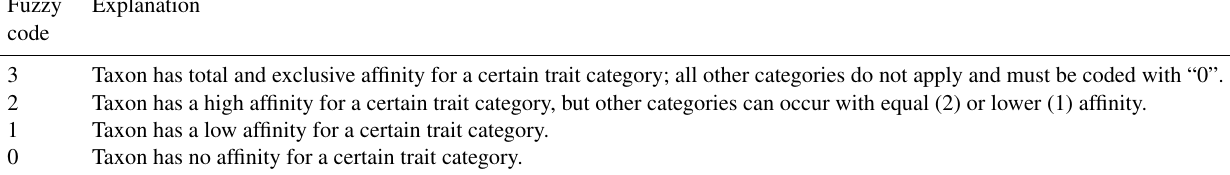
Table 4. Explanation of fuzzy codes as used in the Arctic Traits Database. Fuzzy